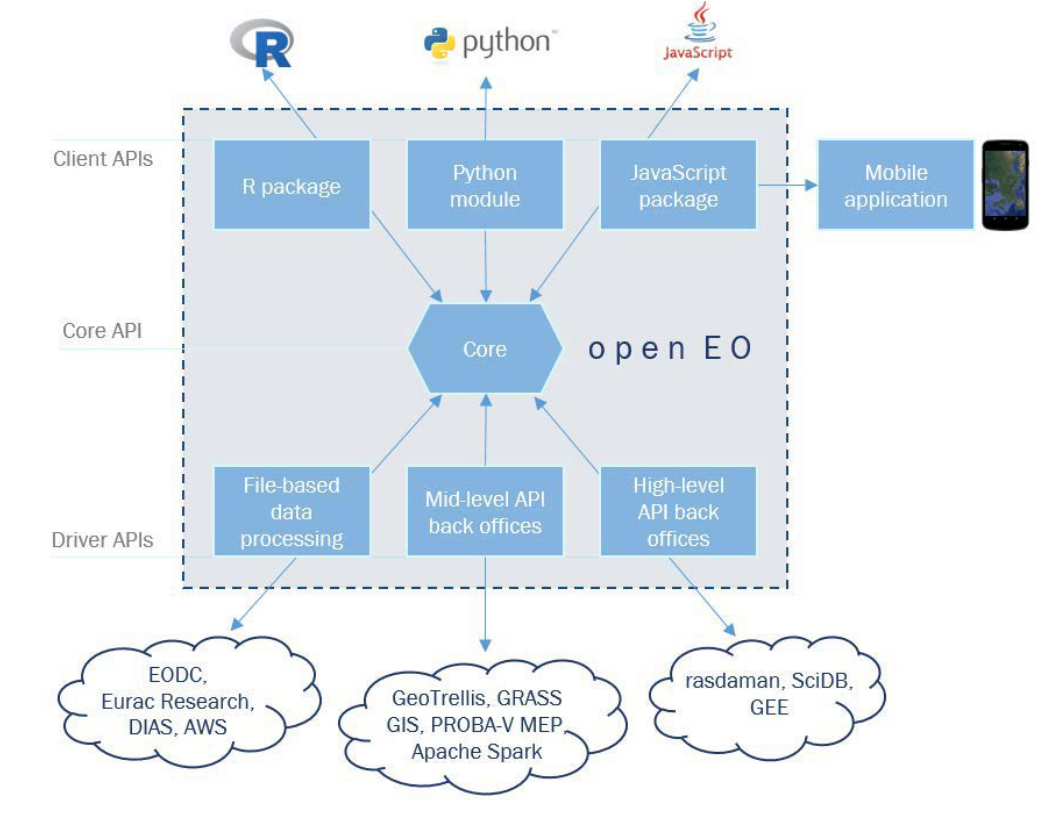
Figure 7. Architecture of the OpenEO project. Source: Pebesma et al.